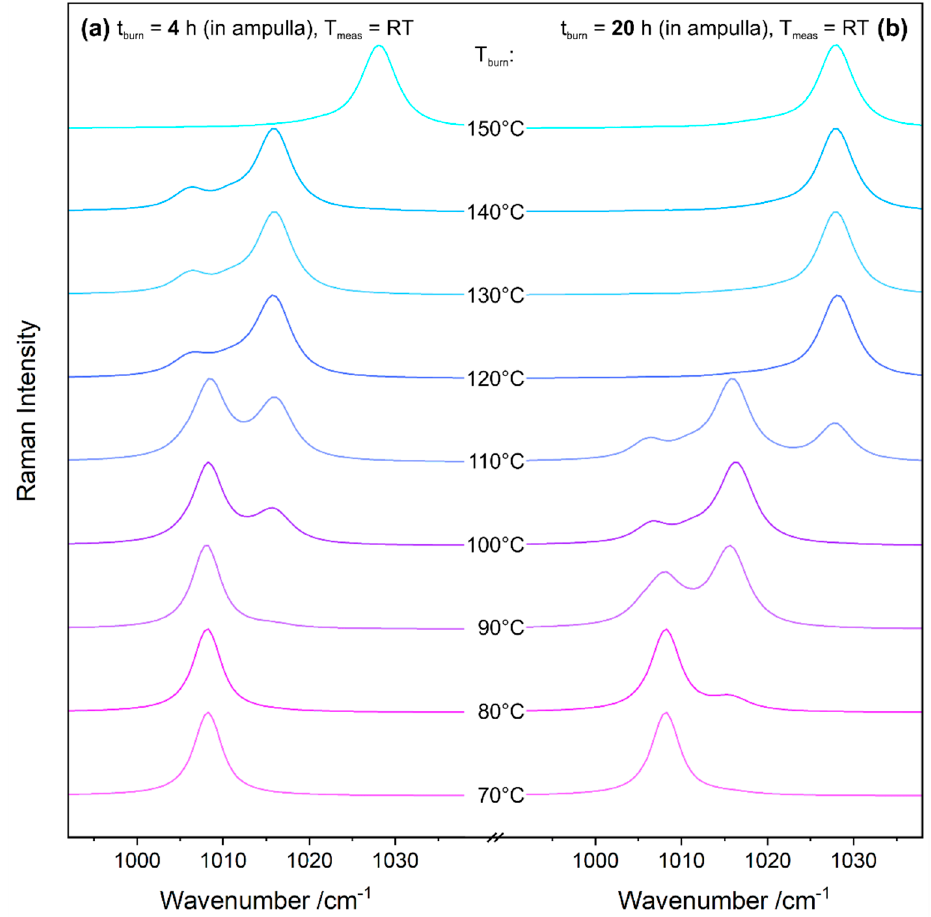
Figure 5. Raman spectra of gypsum calcination products generated in a laboratory furnace.